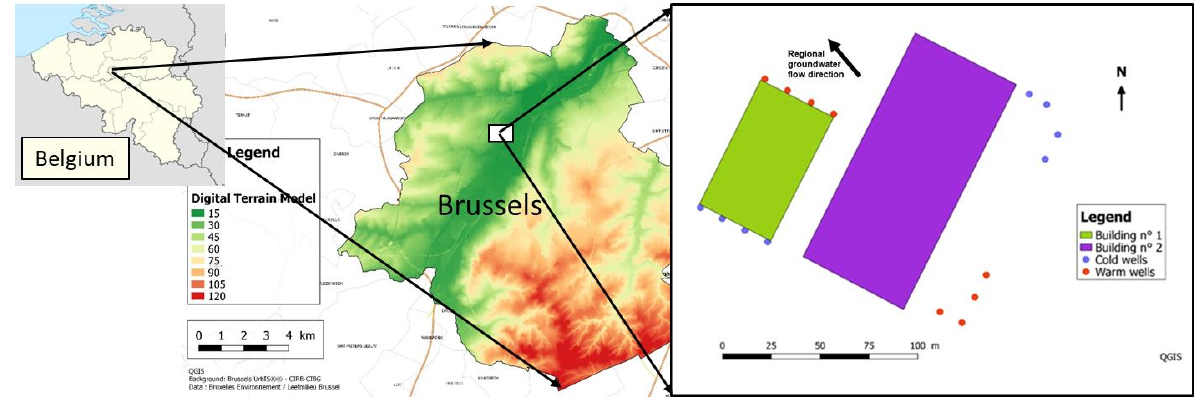
Figure 1. Location map of the study case in Belgium and in Brussels and location of the two studied buildings and their ‘cold’ and ‘warm’ wells belonging to their respective ATES systems.